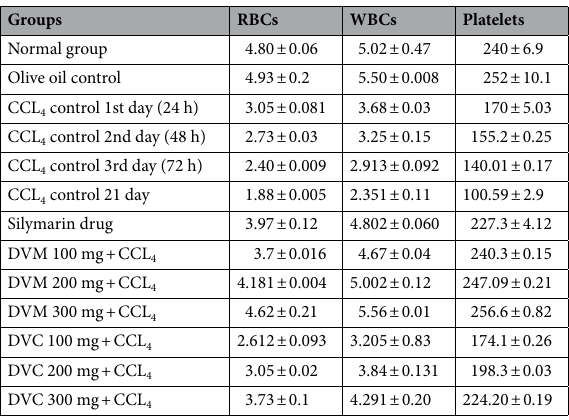
Table 4. Hematological parameters of different groups of mice.